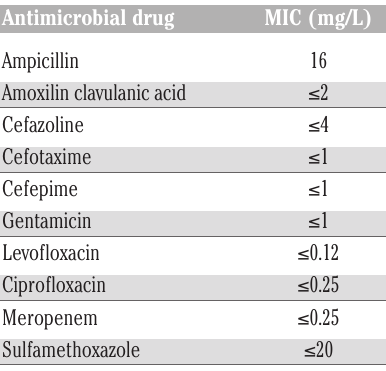
Table 1. Antimicrobial susceptibility pro- file of isolated K. Pneumoniae. Antimicrobial